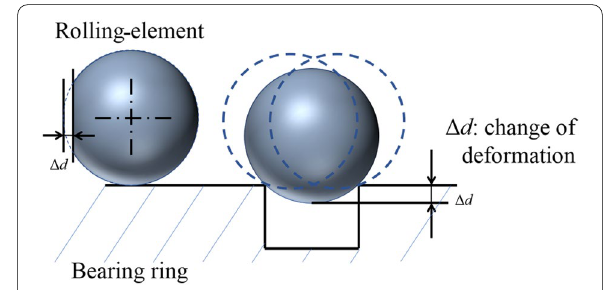
Figure 3 Change of